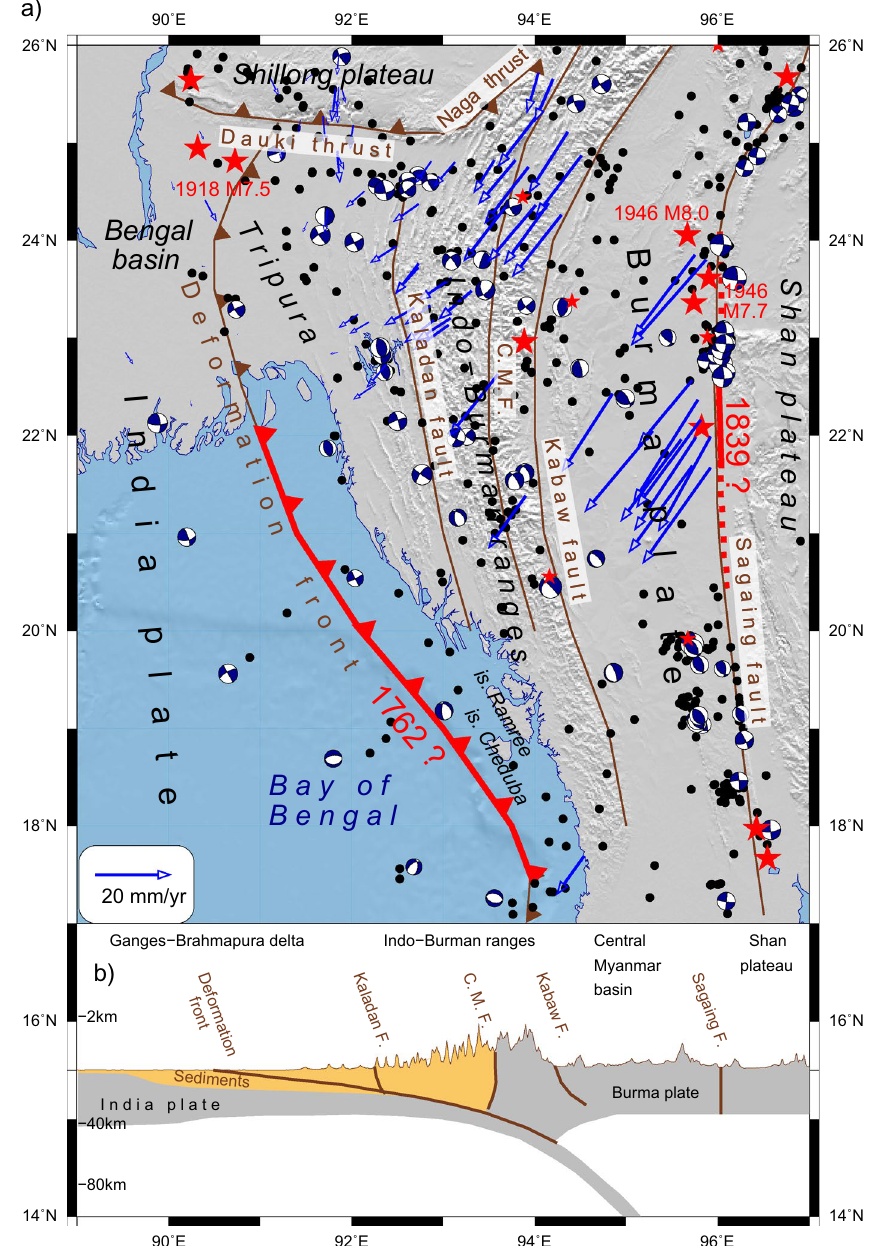
Figure 1. Comprehensive overview of the Indo-Burman megathrust. ( a ) Major faults 4 are shown in brown, CMF is Churachandpur-Mao fault; Black dots and red stars mark shallow (h < 40 km) earthquakes with M ≥ 4.5 (1973–2020) and M ≥ 6.5 (1900–2007) (ANSS, Centennial catalog 9 ). Beach-balls are Fault Plane Solutions (FPS) (GCMT); blue arrows show GPS velocities 3,4,17,32–34 relatively to stable India (Table S1). Large earthquakes discussed in text are labeled. Possible ruptures of the 1762 Arakan earthquake 12 and the 1839 Ava earthquake 8 are traced by red. ( b ) Schematic cross-section at latitude 24°N, modified after 4